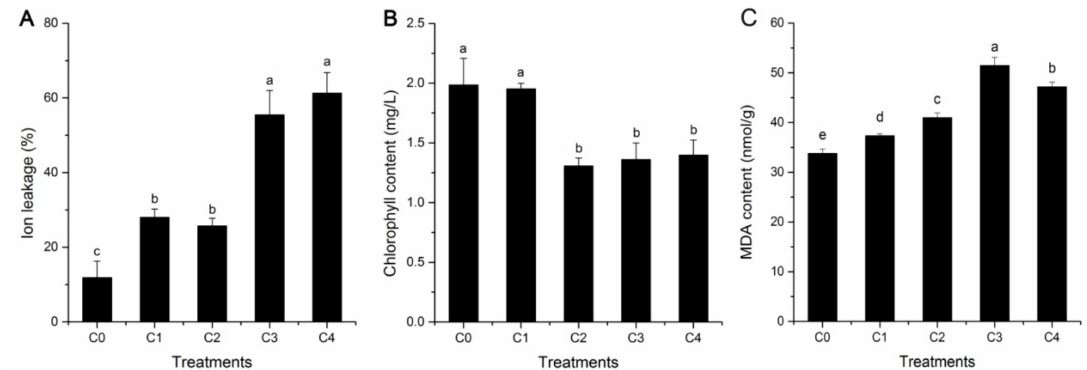
Figure 1. Ion leakage, chlorophyll, and malondialdehyde (MDA) content in leaf tissues of alfalfa, grown under normal and cold stress conditions. ( A ) Ion leakage, ( B ) chlorophyll content, ( C ) MDA content. Leaf tissues were sampled from plants grown under normal conditions and from plants subjected to 4 ◦ C for 2, 6, 24, and 48 h. C0, C1, C2, C3, and C4 represent 0, 2, 6, 24, and 48 h, respectively. Each value represents the mean of three replicates ± SD (standard deviation), shown by a vertical error bar. Different letters above the bars indicate significant differences at the 0.05 level, according to Duncan’s multiple range test. In addition, a, b, c, d, e indicate the result of one-way analysis of variance, and them can reflect significant levels of difference between